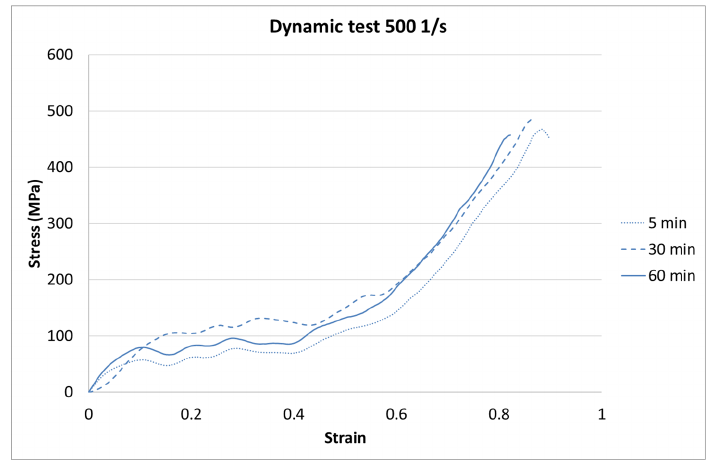
Figure 12. Results of the dynamic test (strain rate of 1000 1/s) of durable resin for curing times of 5, 30, and 60 min for UV and heat exposure.